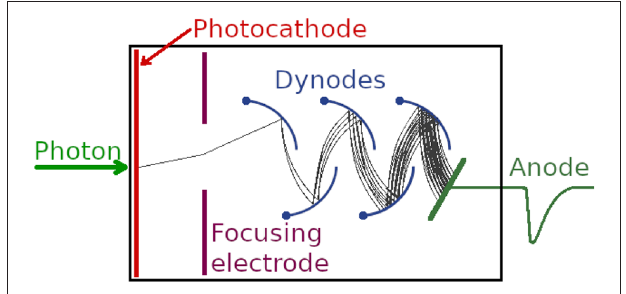
FIGURE 4 | Schematic of a photomultiplier tube. A photon impinging on the photocathode can liberate a photoelectron which is attracted to the first dynode, where further electrons are created by secondary emission. After around 10 dynodes, the gain can be well over 10 6 , producing an output pulse that can be timed by timing electronics [58–61].